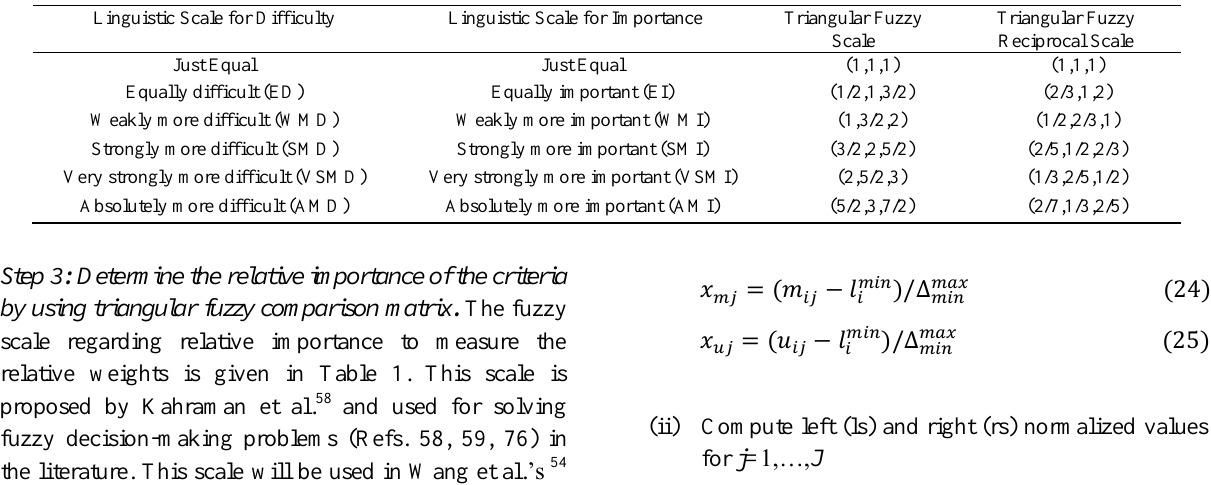
Table 1. Linguistic scales for difficulty and